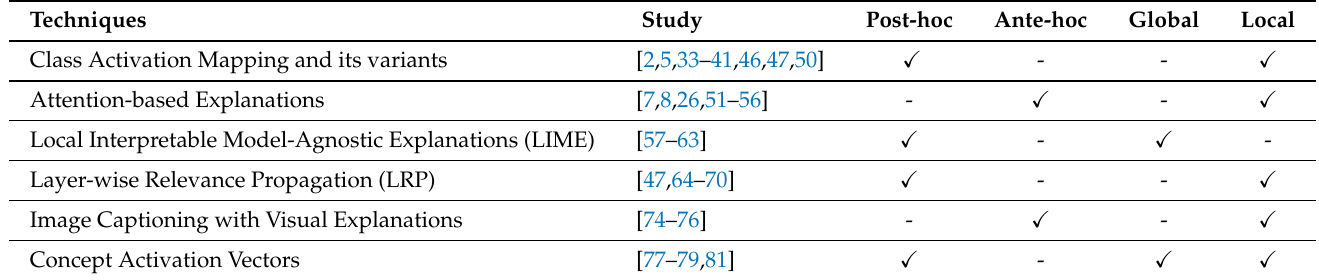
Table 2. List of explainable AI techniques used for medical image analysis and report generation. Checkmarks in the last 4 columns indicate whether each explainable AI technique is post hoc or ante hoc and if it generates global and local